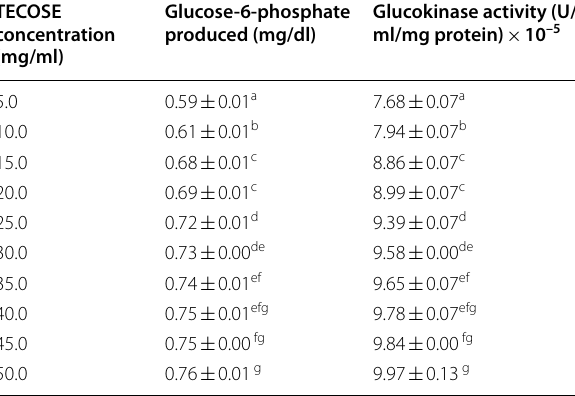
Values are expressed as mean superscripts along the column are statistically significant at p <